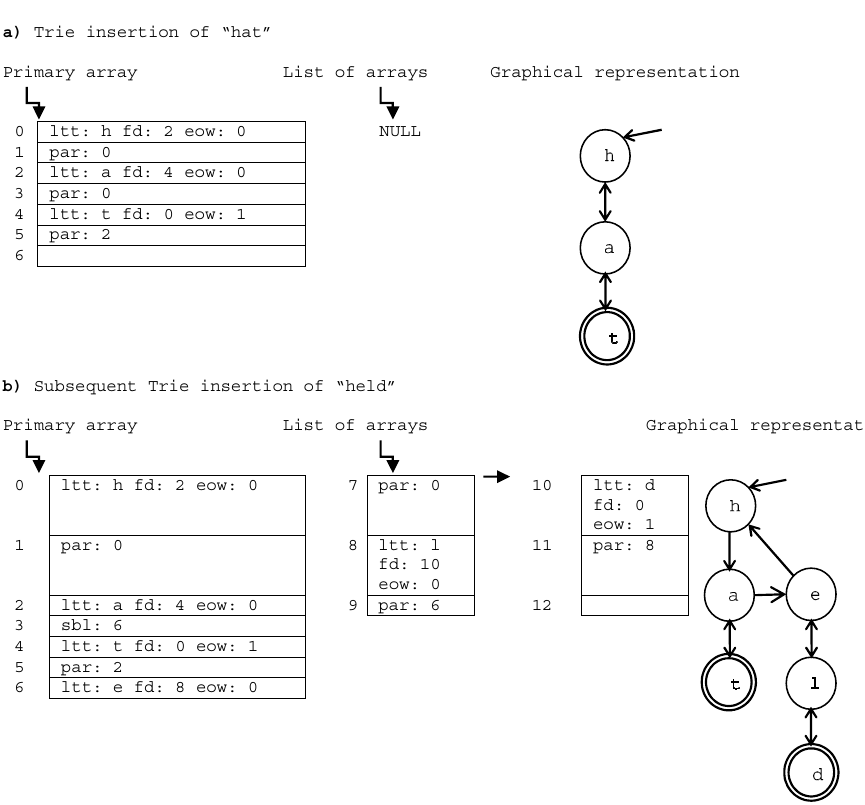
Figure 1. Sequential and graphical representations of Trie (ltt: letter; fd: first descendent index; eow: end of word; par: parent index; sbl: sibling index; BN0 = 7; BN = 3) that indexes the terms hat and held